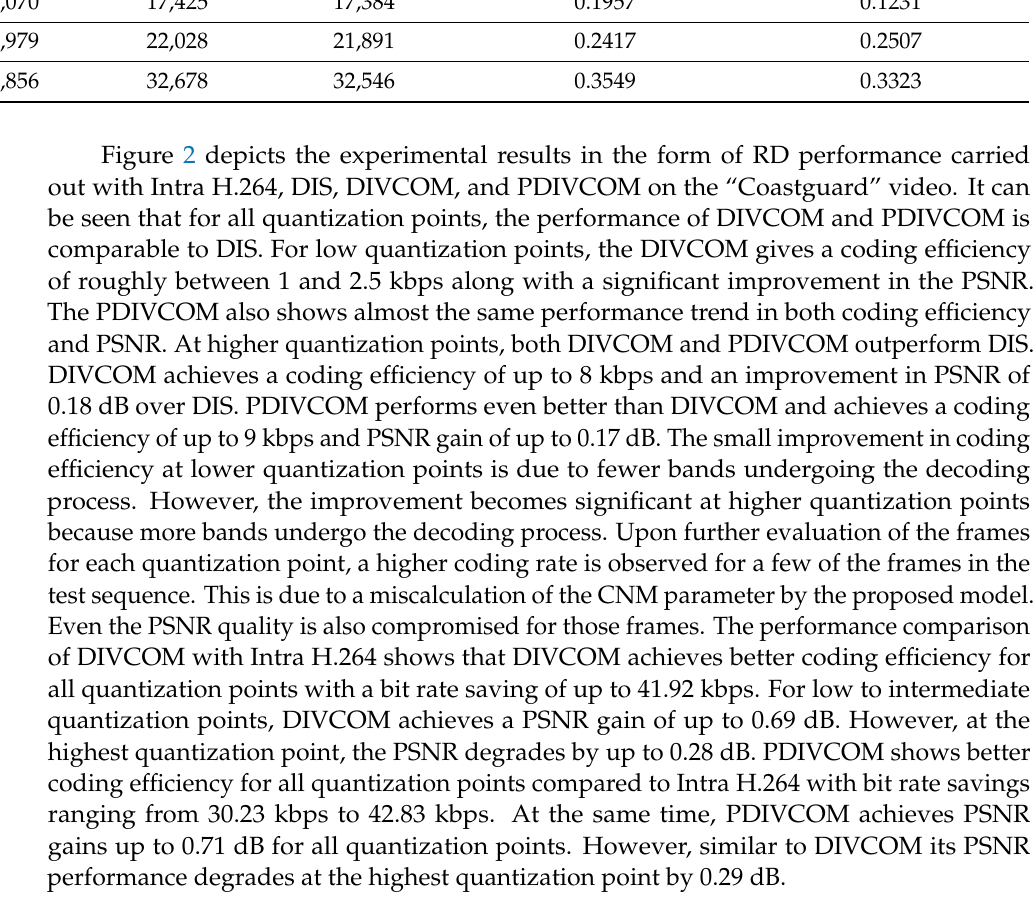
Table 3. Coding efficiency evaluation of proposed novel online CNM for “Coastguard” video se- quence.